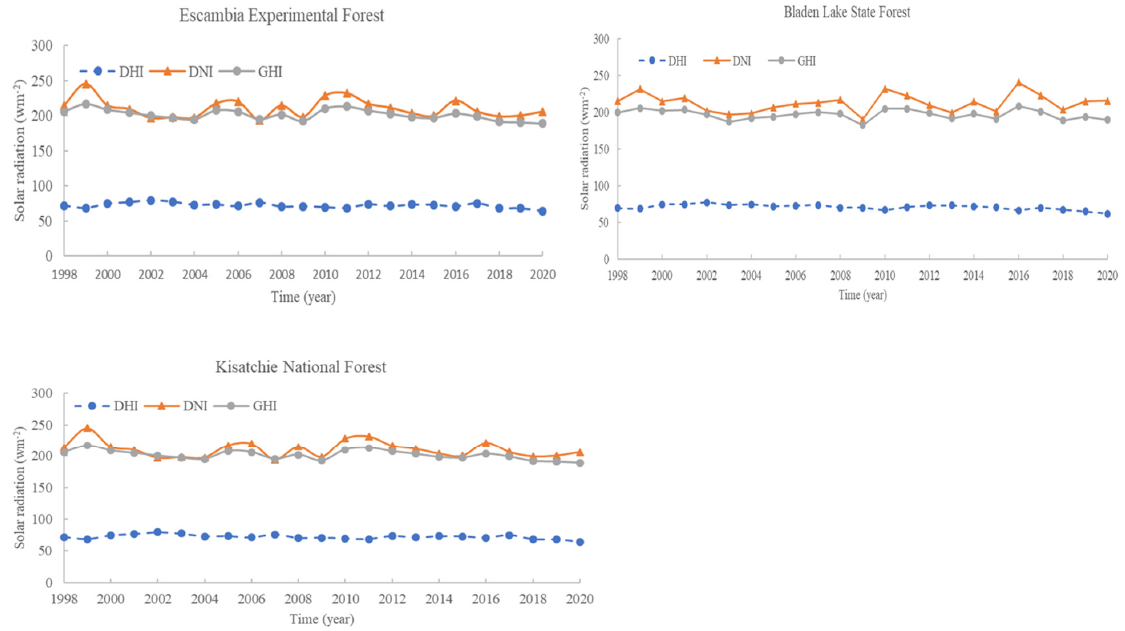
Figure 3. The solar radiation dynamics of the three indices (DHI, DNI, GHI) from 1998 to 2020 at the three sites.